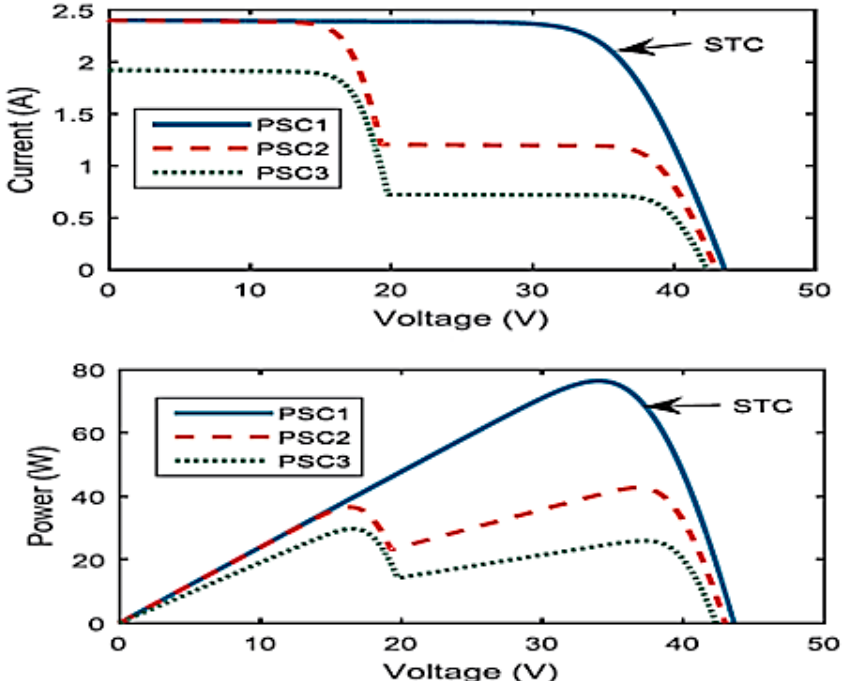
Figure 6. Different partial shading patterns, Voltage-current and voltage-power curves (Vikram Solar ELDORA-37 modules) [28].